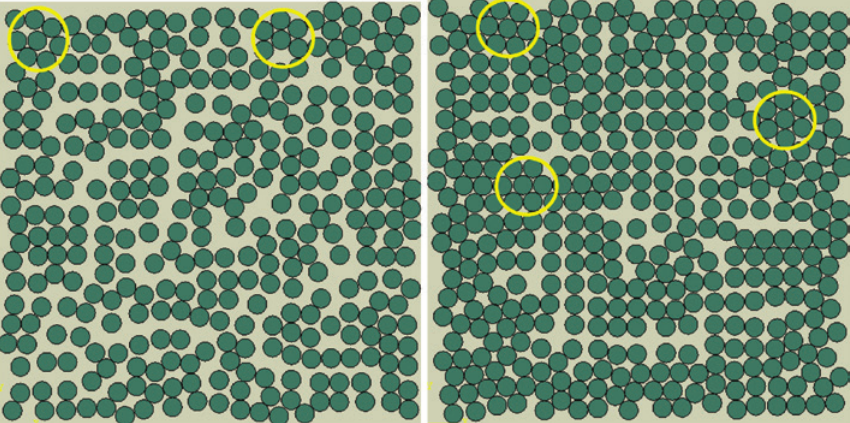
Figure 7: Development of hexagonal cells with the higher volume